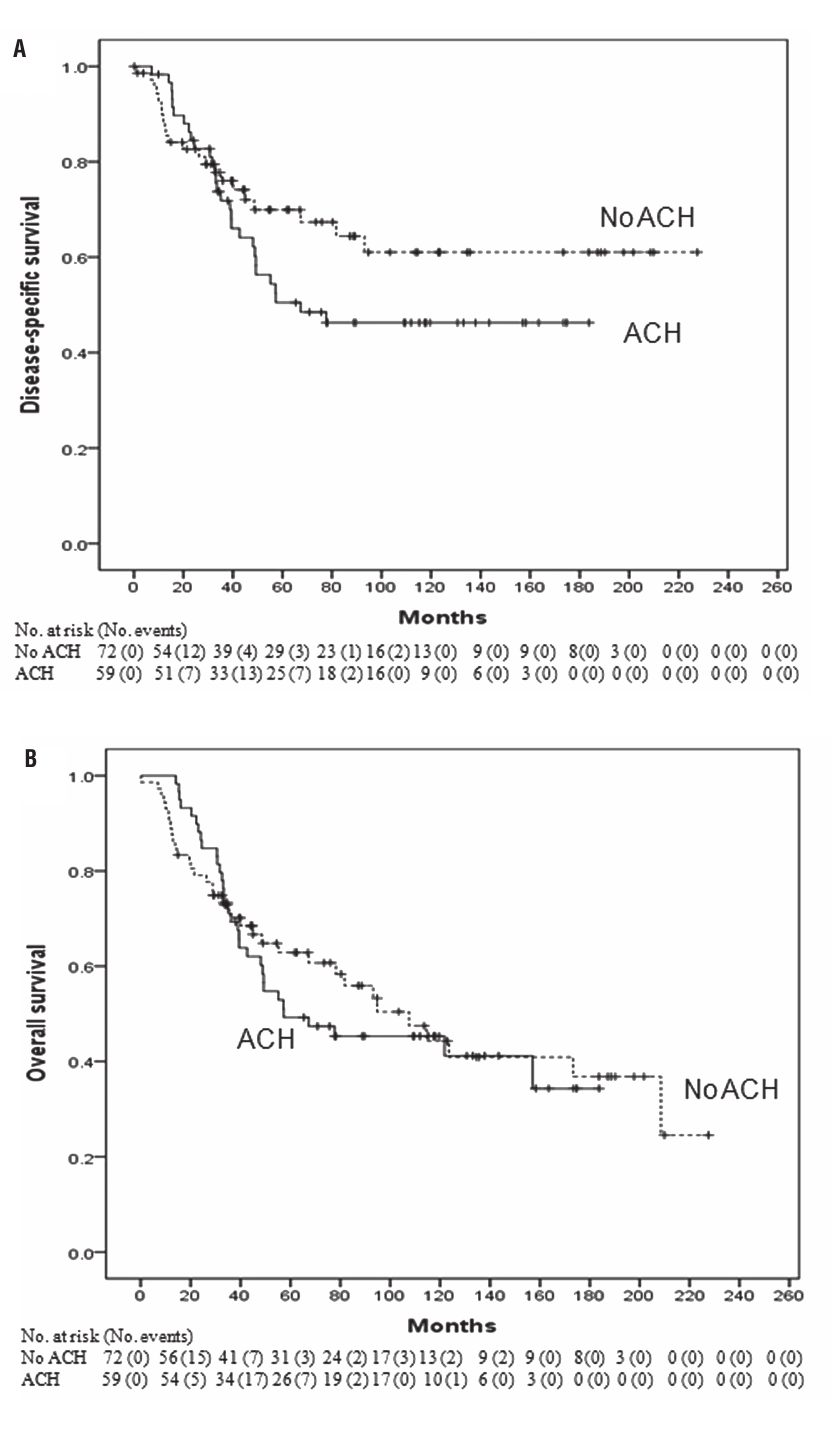
supplementary figure-1: Kaplan–Meier analysis for (A) disease-specific survival and (B) overall survival after radical nephroureterectomy stratified by the administration of adjuvant chemotherapy in patients who received cisplatin-based adjuvant chemotherapy or